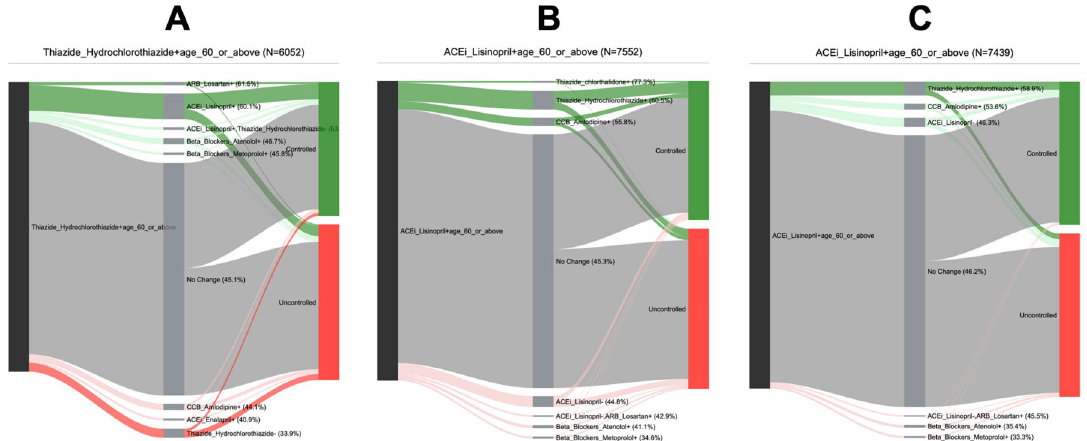
Figure 5. Personalized treatment options for three different HTN patient decision points. ( A ) The patient decision point belongs to a filter variable group that is over age 60 and on Hydrochlorothiazide (Thiazide). ( B , C ) The patient decision point belongs to a filter variable group that is over age 60 and on Lisinopril (ACEI). Note that the treatment options associated with significantly better control (dark green pathways) across the three patient decision points are